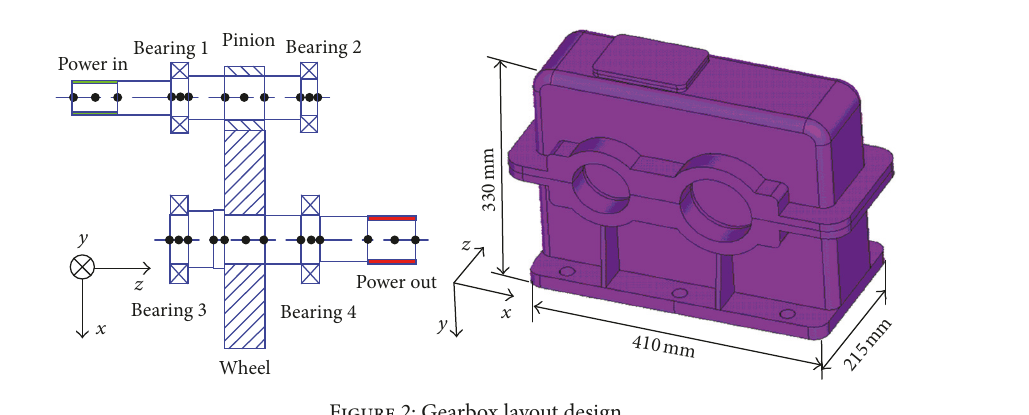
Figure 2: Gearbox layout design.